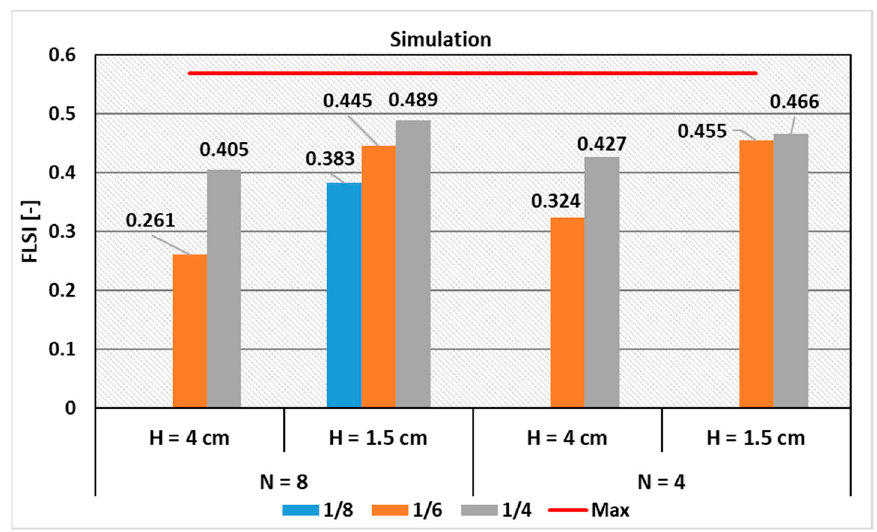
Figure 5. The front layer segregation index (FLSI) from simulations for bi-size bed and different baffles configurations.